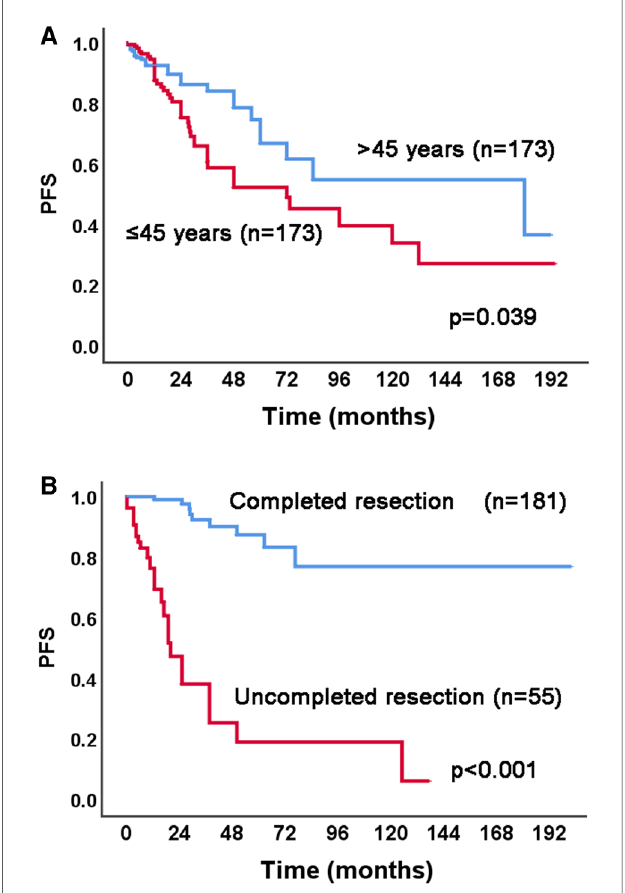
FIGURE 3 Kaplan – Meier analysis of high-risk factors for PFS in 38 IVL patients from Qilu hospital of shandong university. PFS, progression-free survival; IVL, intravenous leiomyomatosis.